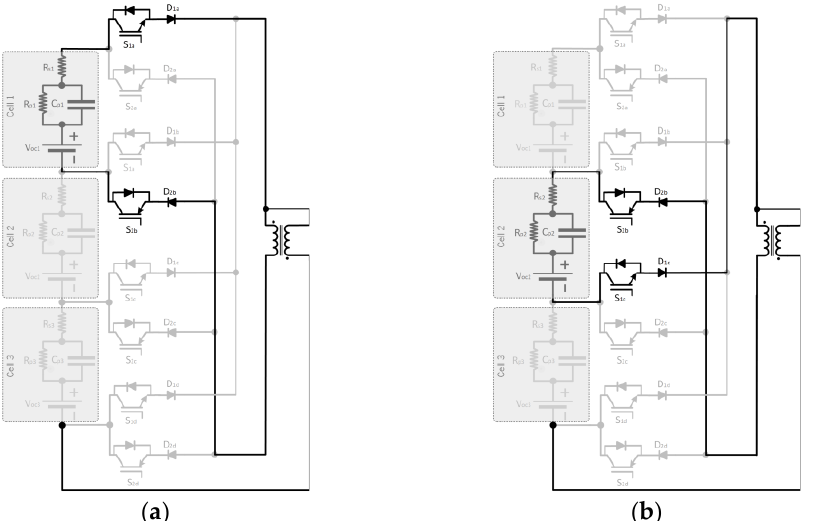
Figure 18. Operating modes of the SF converter: ( a ) discharging of cell 1; ( b ) charging of cell 2.